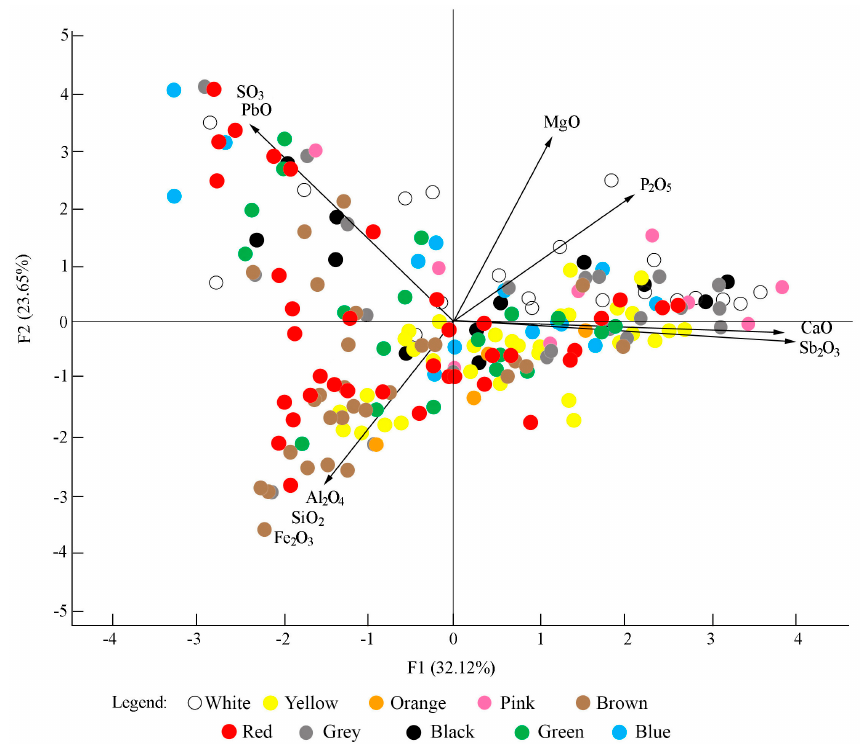
Figure 4. Principal component analysis for the compositional data for all paints in the frescoes. The arrows are the main vectors. The length of the arrow is in agreement with the importance of the vector.